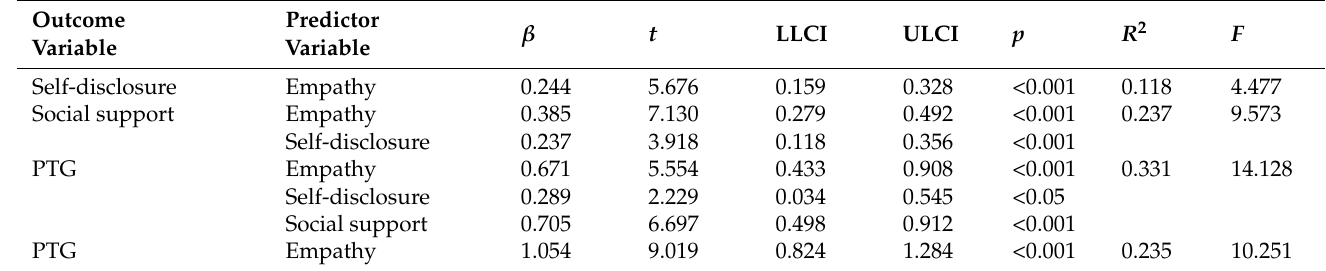
Table 3. Regression analysis of the relationship between variables. ( N = 414).